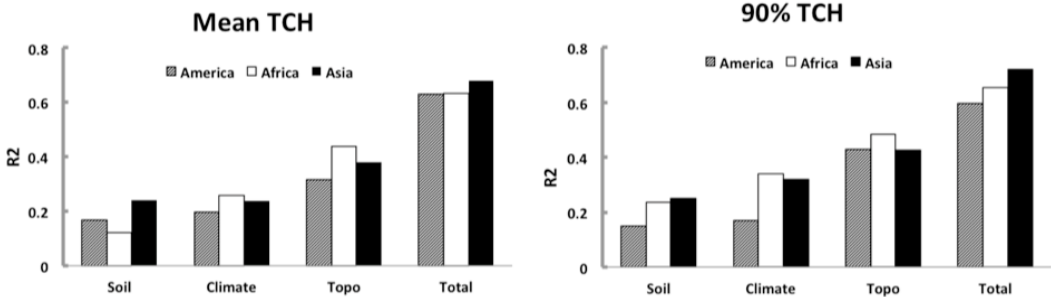
Figure 3. Contributions of soil, climate and spatial features to forest tree heights in terms of partial R2. In the “Topo” columns, we included spatial (geographic latitude/longitude) information together with the terrain data (SRTM and SRTM_SD).